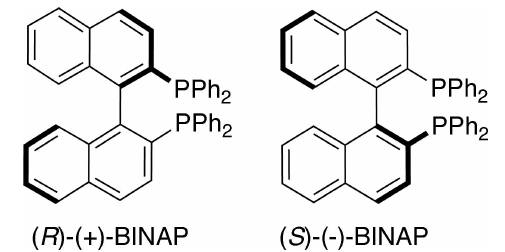
Figure 1 BINAP atropisomers.